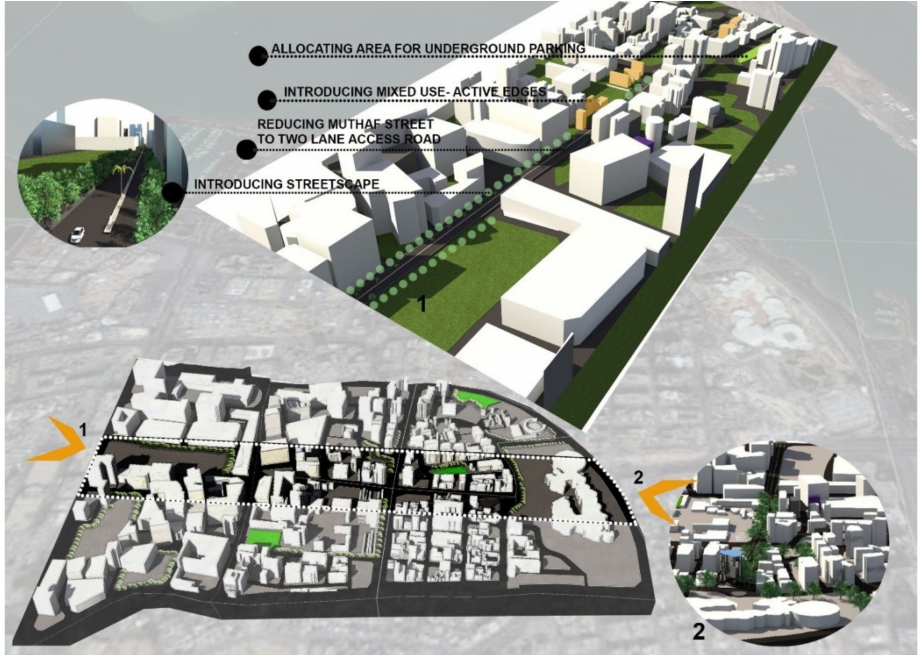
Figure 10. Place-making considerations along Muthaf